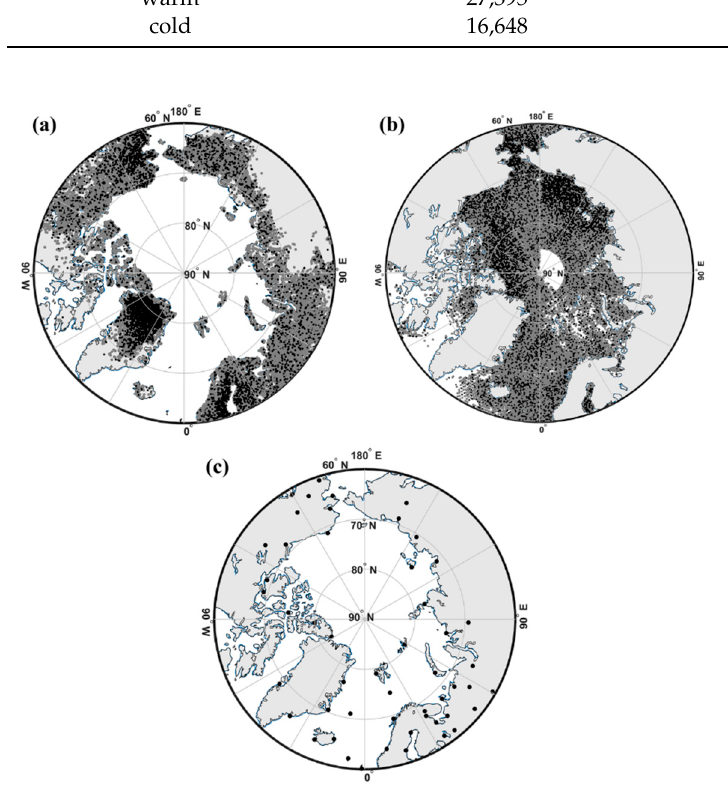
Figure 1. ( a , b ) Distribution of samples on land and ocean obtained under clear-sky conditions in the Arctic region, respectively. Gray solid points represent test samples; black solid points represent training samples. ( c ) Distribution of radiosonde stations in the arctic. The solid dots represent the radiosonde stations.